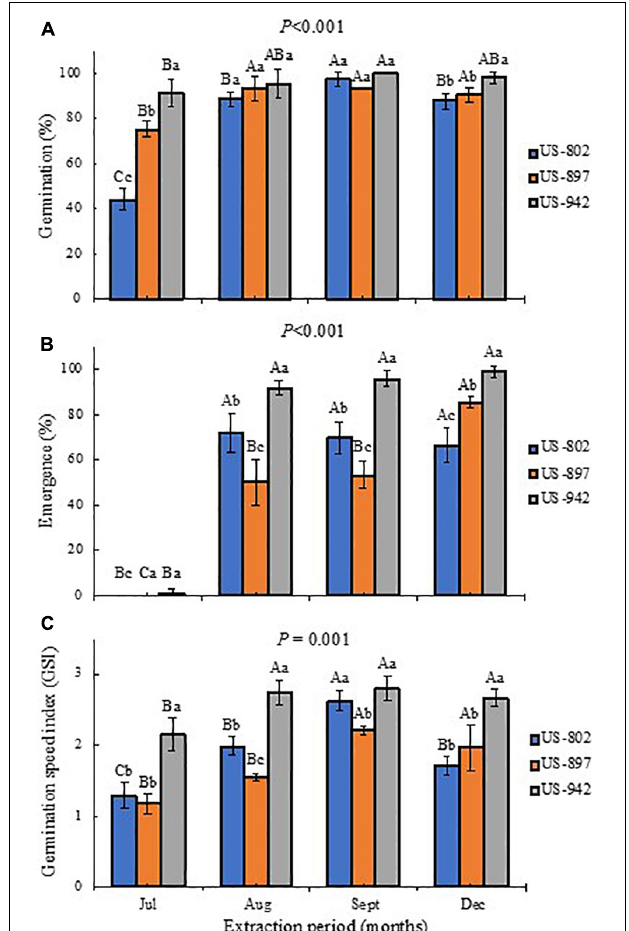
FIGURE 4 | Percentage of germination (A) , emergence (B) , and germination speed index (C) of three citrus rootstocks during different period of seed extraction at the Southwest Florida Research and Education Center, Immokalee, FL, United States. Bars followed by the same lowercase and capital letter do not significantly differ in regard to rootstock and seed extraction period, respectively, according to the Tukey’s test ( P ≤